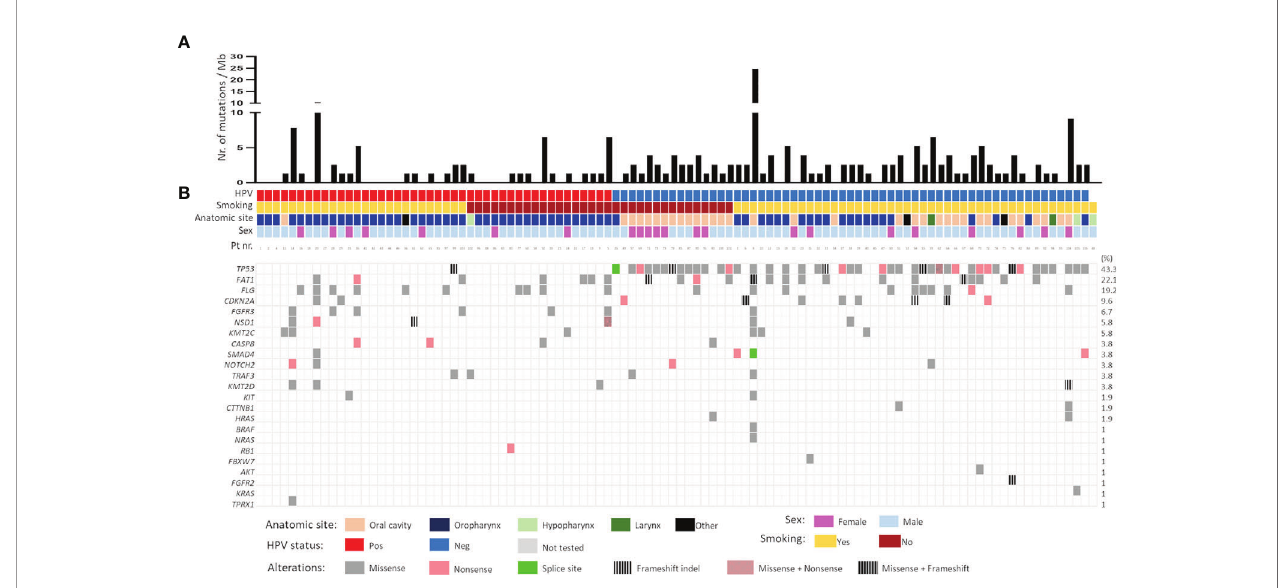
FIGURE 2 | (A) Mutational burden and (B) mutational spectrum of head and neck squamous cell carcinomas as detected by targeted sequencing. Samples were strati fi ed according to HPV status followed by smoking status. Gene list is shown on the left whereas the corresponding frequency of mutation is shown on the right. Pos- positive; Neg-